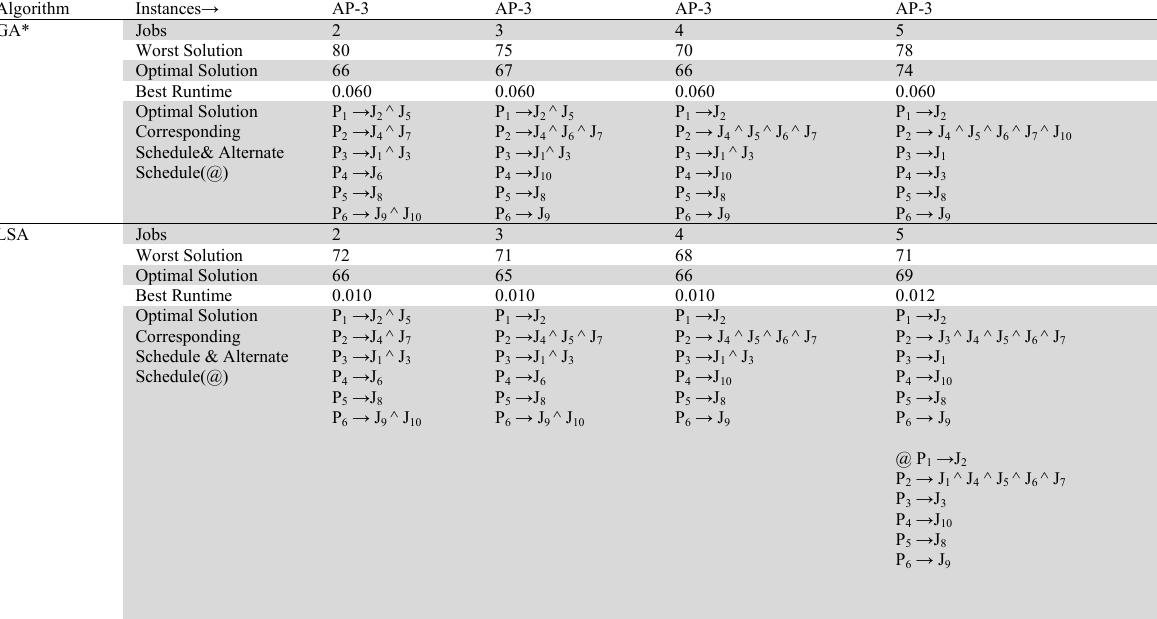
Comparative results of LSA against GA* for AP-3